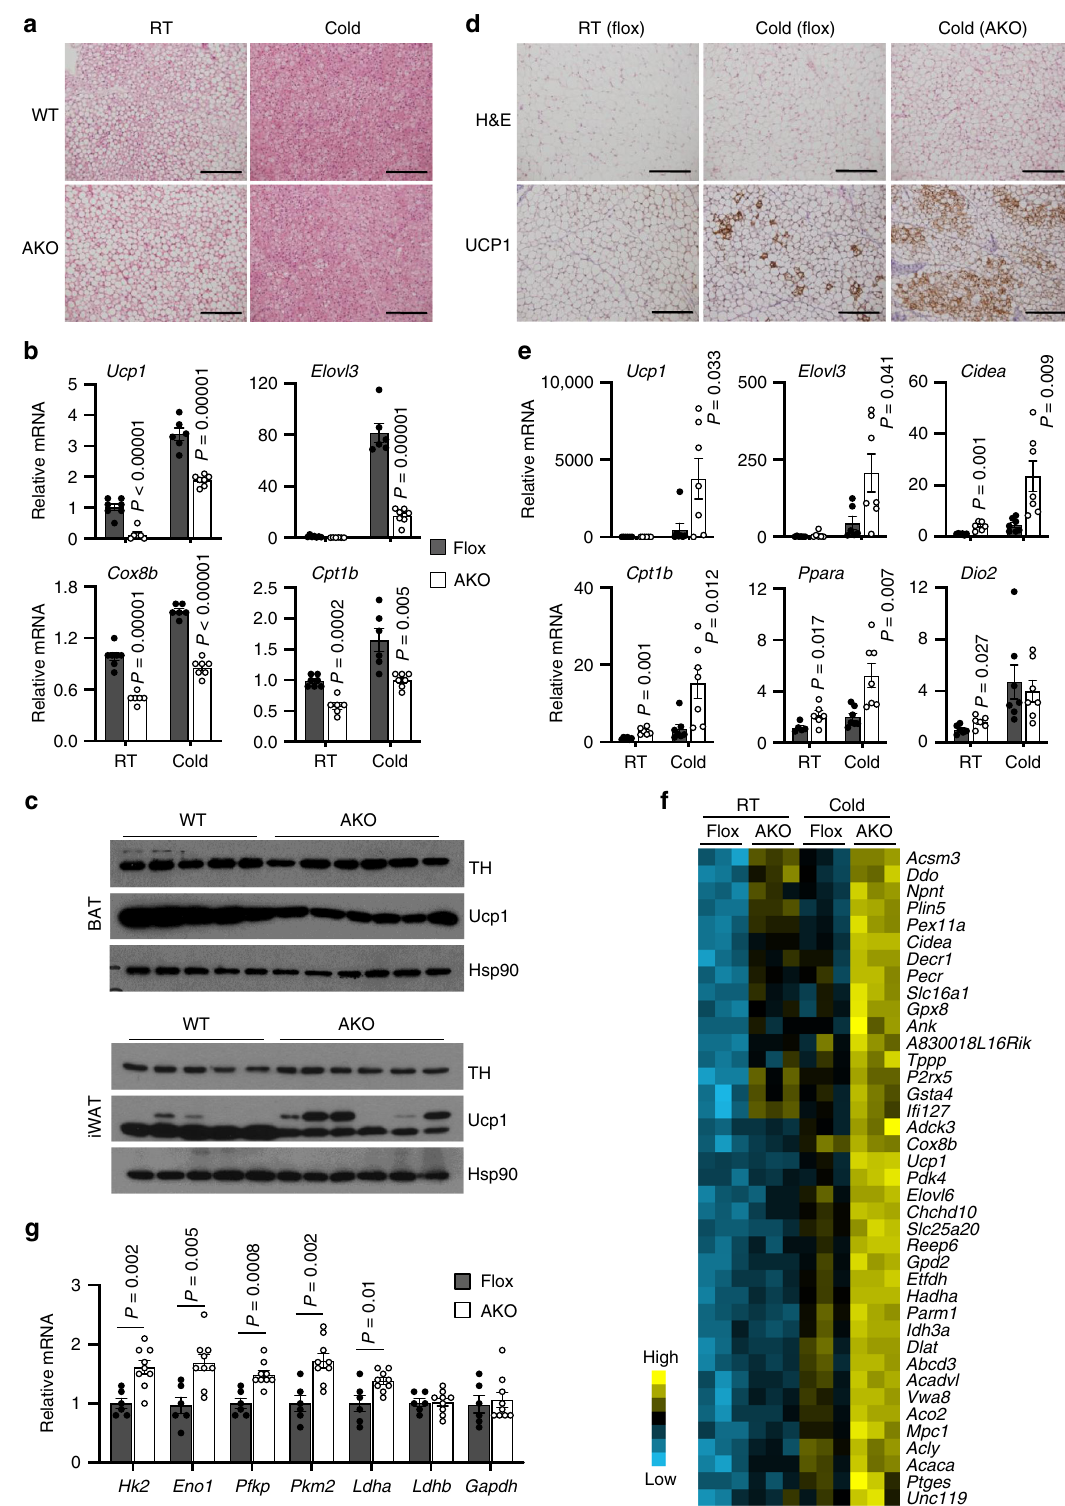
Fig. 4 BAF60a de fi ciency promotes cold-induced beige fat formation. a H&E staining of BAT from mice kept at ambient room temperature (RT) or after cold acclimation (Cold) (scale bar = 200 μ m; n = 4 per group). b qPCR analysis of BAT gene expression ( fl ox, n = 7 for RT, n = 6 for Cold; AKO, n = 6 for RT, n = 7 for Cold). c Immunoblots of brown fat and inguinal fat lysates. d H&E and UCP1 immunostaining of iWAT sections (scale bar = 200 μ m) ( fl ox, n = 6 for RT, n = 7 for Cold; AKO, n = 8 for Cold). e qPCR analyses of iWAT gene expression ( fl ox, n = 6 for RT, n = 6 for Cold; AKO, n = 6 for RT, n = 7 for Cold). f Heatmap representation of microarray data showing a cluster of genes exhibiting elevated expression in AKO iWAT following cold acclimation. g qPCR analysis of genes enriched in glycolytic beige fat ( fl ox, n = 6, fi lled; AKO, n = 9, open). Data in b , e , g represent mean ± s.e.m. two-tailed unpaired Student ’ s t test, fl ox vs. AKO. Source data are provided as a Source Data fi